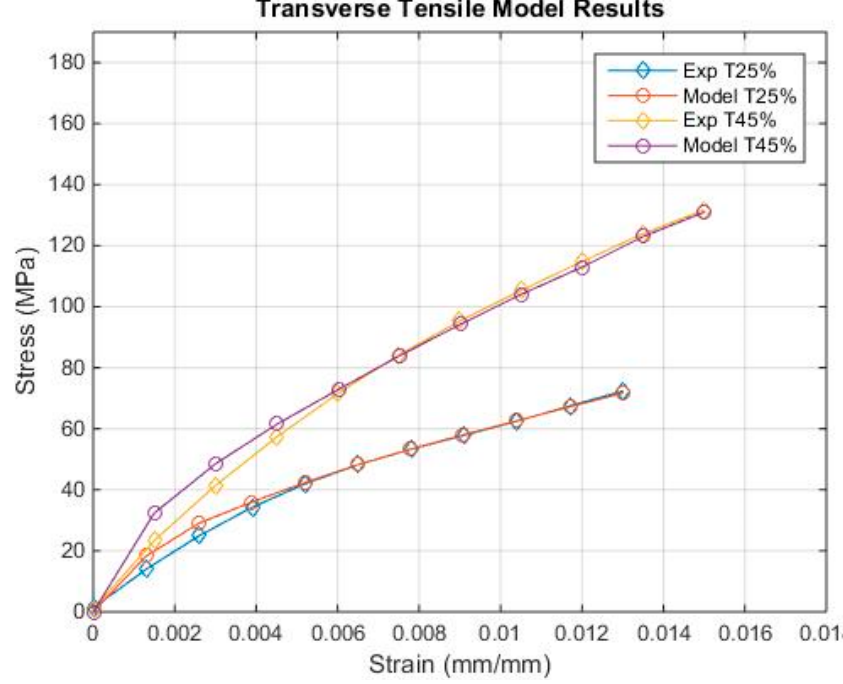
Figure 11. Uniaxial tension experimental and simulated stress–strain curves for the transverse direction.